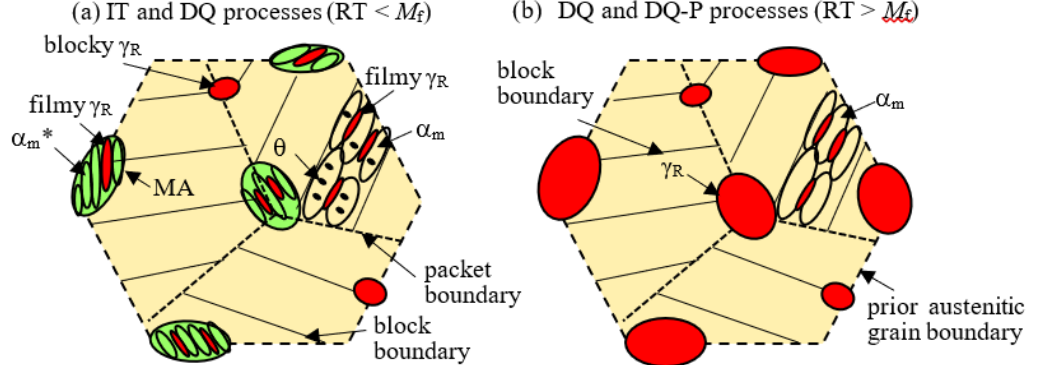
Figure 4. Illustration of typical microstructures of advanced martensitic steels (AMSs) subjected to ( a ) the IT and DQ processes in the case of RT < M f and ( b ) the DQ and DQ-P processes in the case of RT > M f . RT: room temperature. α m , α m *, γ R , θ and MA represent coarse lath-martensite, fine lath/twin-martensite, retained austenite, carbide and MA phase, re- spectively.